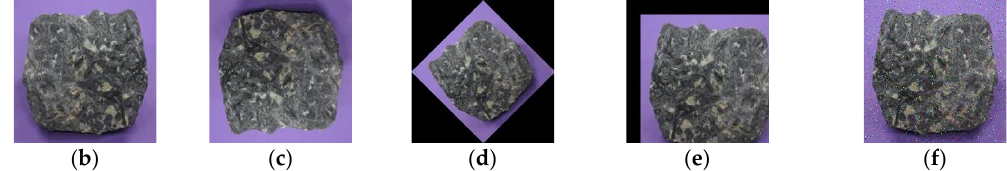
Figure 1. Example of amphibolite image enhancement. ( a ) Original image; ( b ) Horizontal Flip; ( c ) Vertical Flip; ( d ) Random rotation; ( e ) Image panning; ( f ) Gaussian noise wave. Table 2. Distribution of original number, enhanced number and training test samples of rock da- taset.